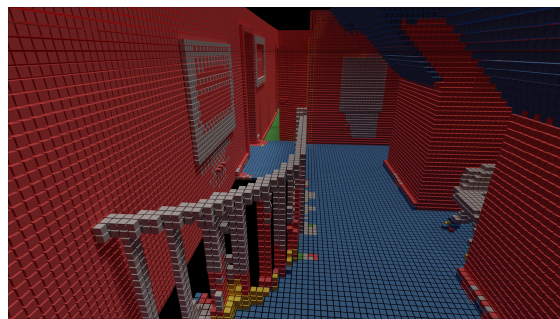
Figure 12. Floor level difference in hall has been wrongly labelled as ceiling.